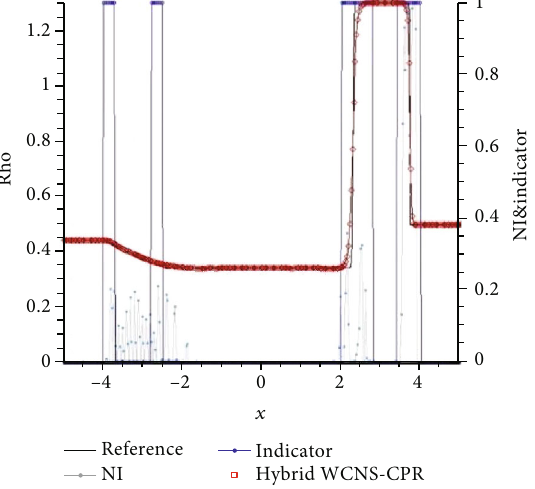
Figure 10: Density numerical solution and shock detection result of the hybrid WCNS-CPR scheme for the 1D Lax